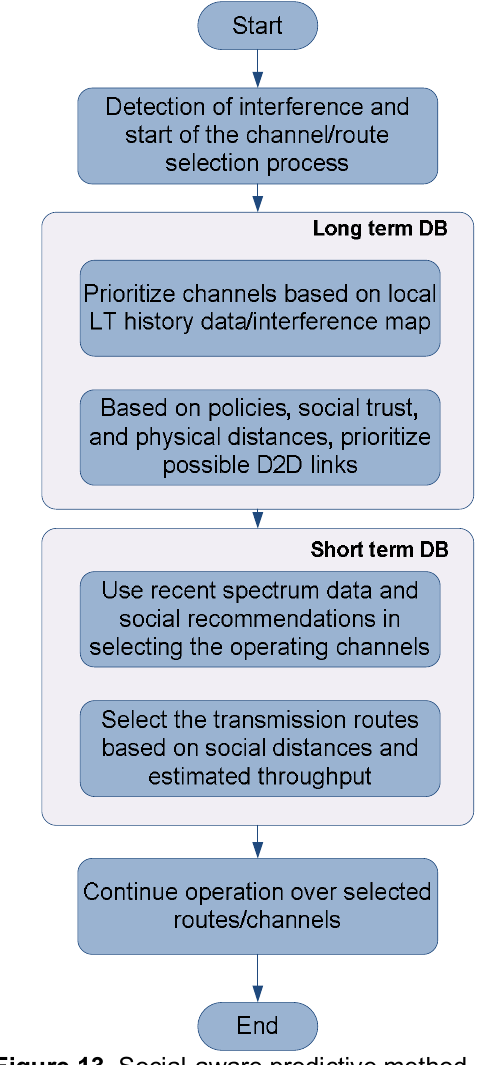
Figure 13. Social-aware predictive